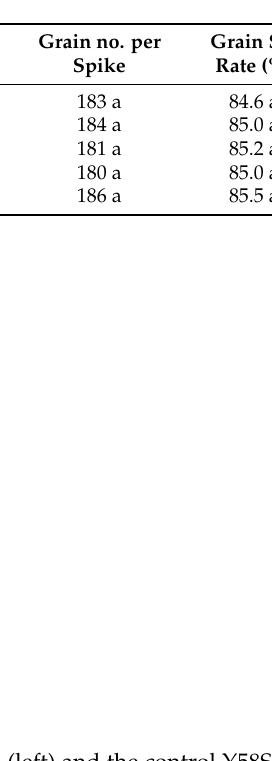
(right) (bar= 10 cm).